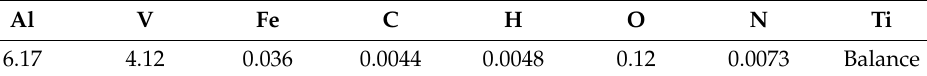
Figure 1. Material for experiments: ( a ) prepared profile; ( b ) section size (mm). Table 1. Chemical composition of Ti-6Al-4V alloy profile (wt%).